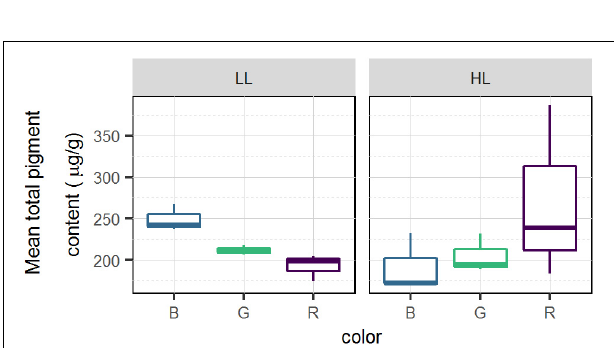
FIGURE 7 | Average total pigment content ( µ g.g − 1 ) for each light color and intensity in migrational biofilm ( n = 3). Pigments were sampled on the top 2 mm of the sediment using contact